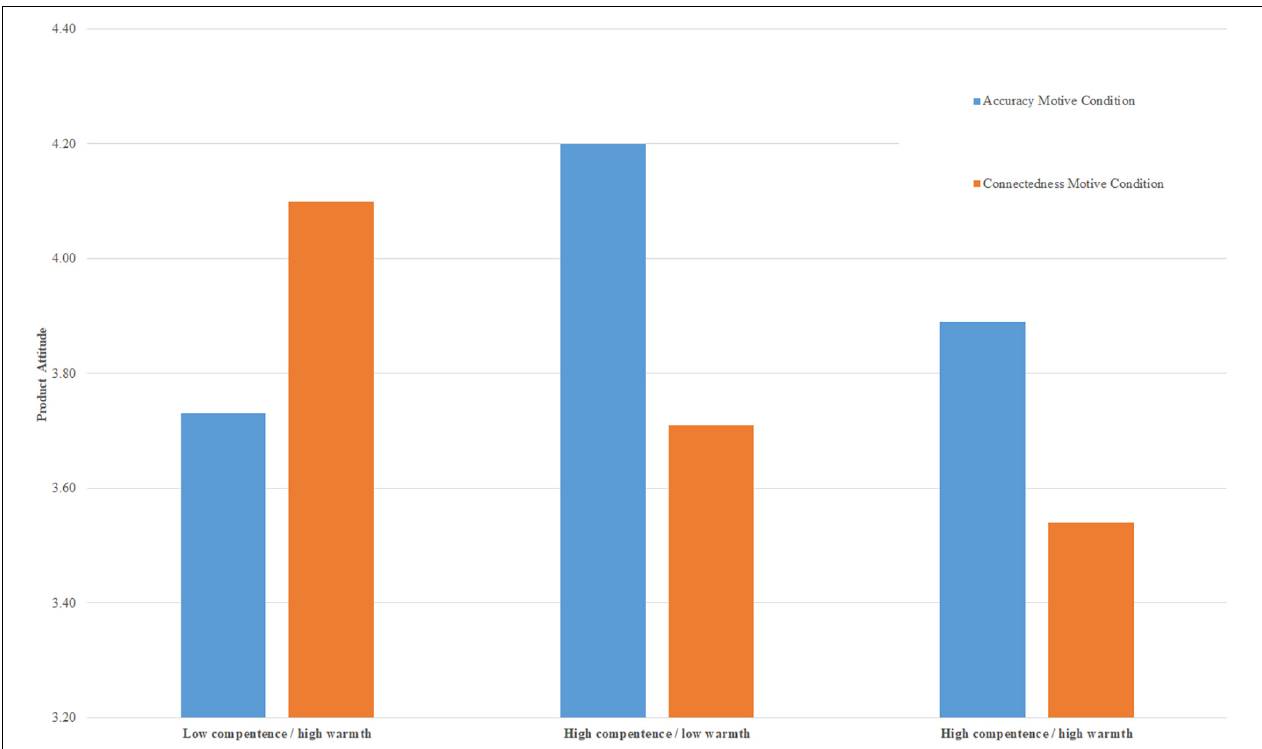
FIGURE 1 | Condition means for product attitudes in Study 2. The lc/hw groups are comprised of housewives and disabled persons (averaged), the hc/lw groups are comprised of career women and lawyers (averaged); the hw/hc group is students.